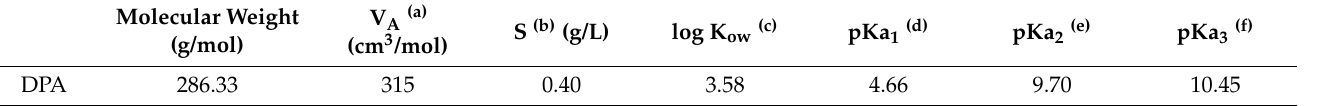
Table 1. Physicochemical properties of DPA.